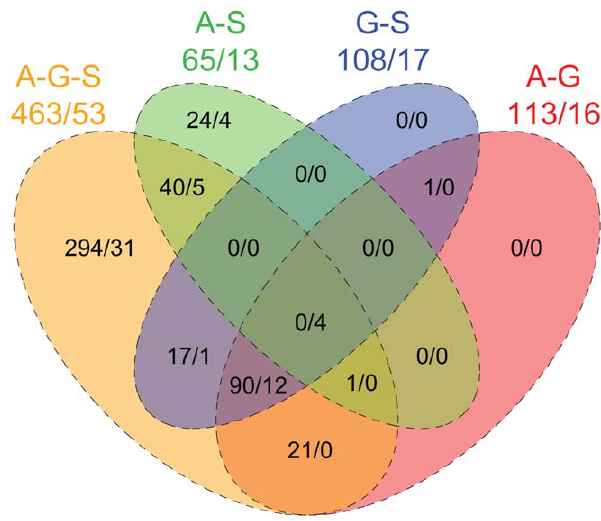
Figure 6. Venn diagram showing the intersect between the four outlier detection analyses. Each ellipse represents the consensus of three independent runs of BayeScan, for the three population pairs (A-G, A-S, G-S), and all populations (A-G-S). Numbers correspond to the total number of outlier SNPs (left of slash) and corresponding contigs (right of slash) for each analysis.